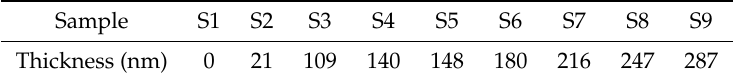
Table 1. As-fabricated silicon wafer with different SiO 2 passivation